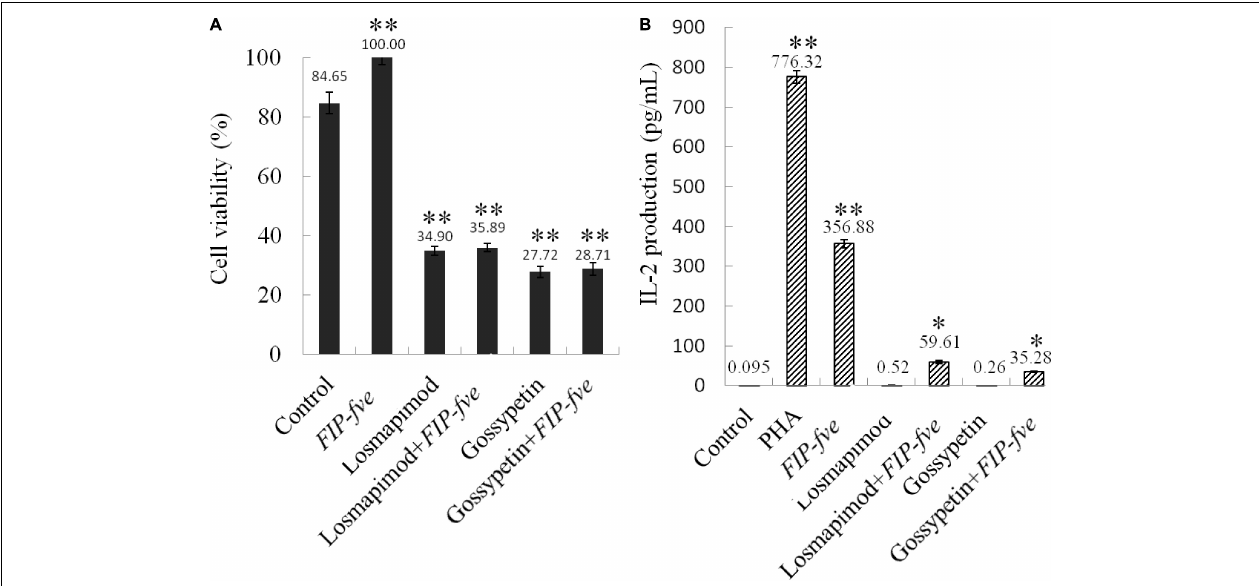
FIGURE 5 | Gossypetin and losmapimod inhibit cell proliferation and IL-2 release in FIP-fve -induced Jurkat E6-1 cells. (A) Gossypetin and losmapimod attenuated proliferation of FIP-fve -induced Jurkat E6-1 cells. Cell viability was determined after treatment within RPMI 1640 medium supplemented with 10% fetal bovine serum FIP-fve (100 µ g/ml) and/or Losmapimod (0.1 µ M/ml) and/or Gossypetin (40 µ M/ml) for 12 h. Values are mean ± standard deviation, n = 3. PHA (5 µ g/ml) was used as a positive control. (B) Gossypetin and losmapimod inhibit FIP-fve -induced IL-2 release in Jurkat E6-1 cells. IL-2 release was detected by ELISA kit for human IL-2 after treatment with as in (A) for 6 h. Values are mean ± SD, n = 3, * p < 0.05, ∗∗ p < 0.01.